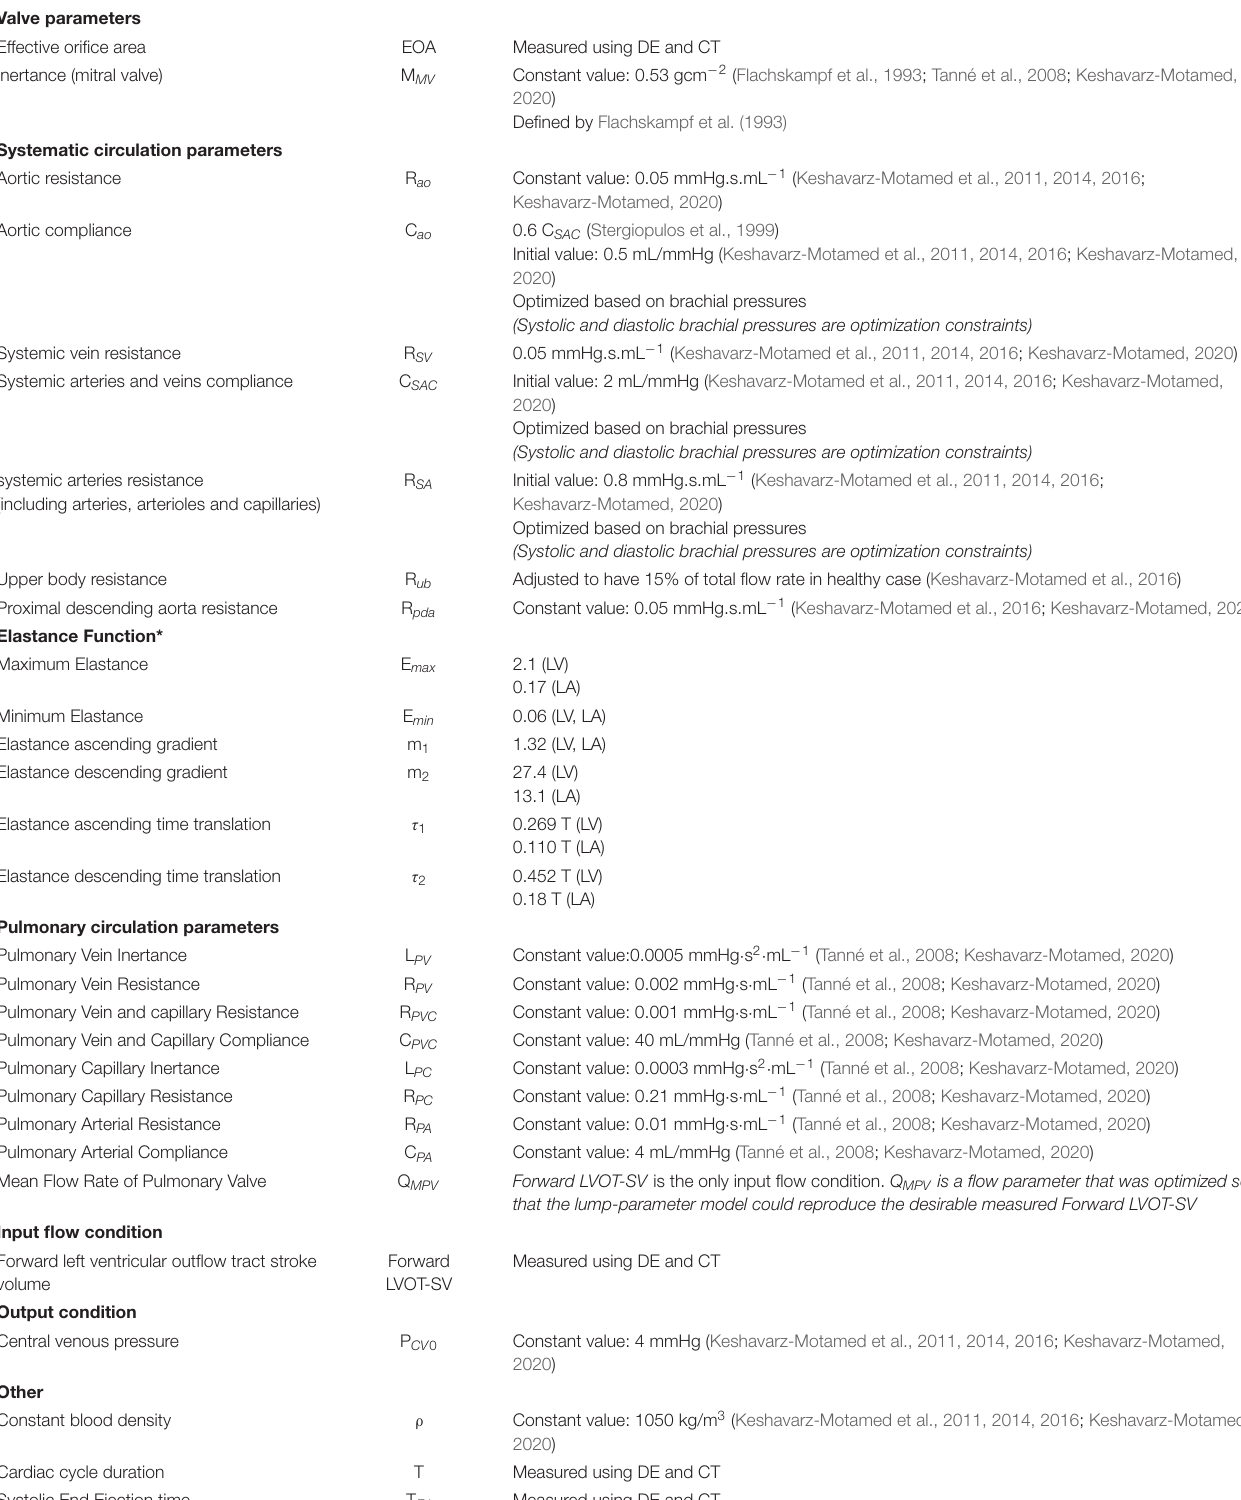
TABLE 1 | Cardiovascular